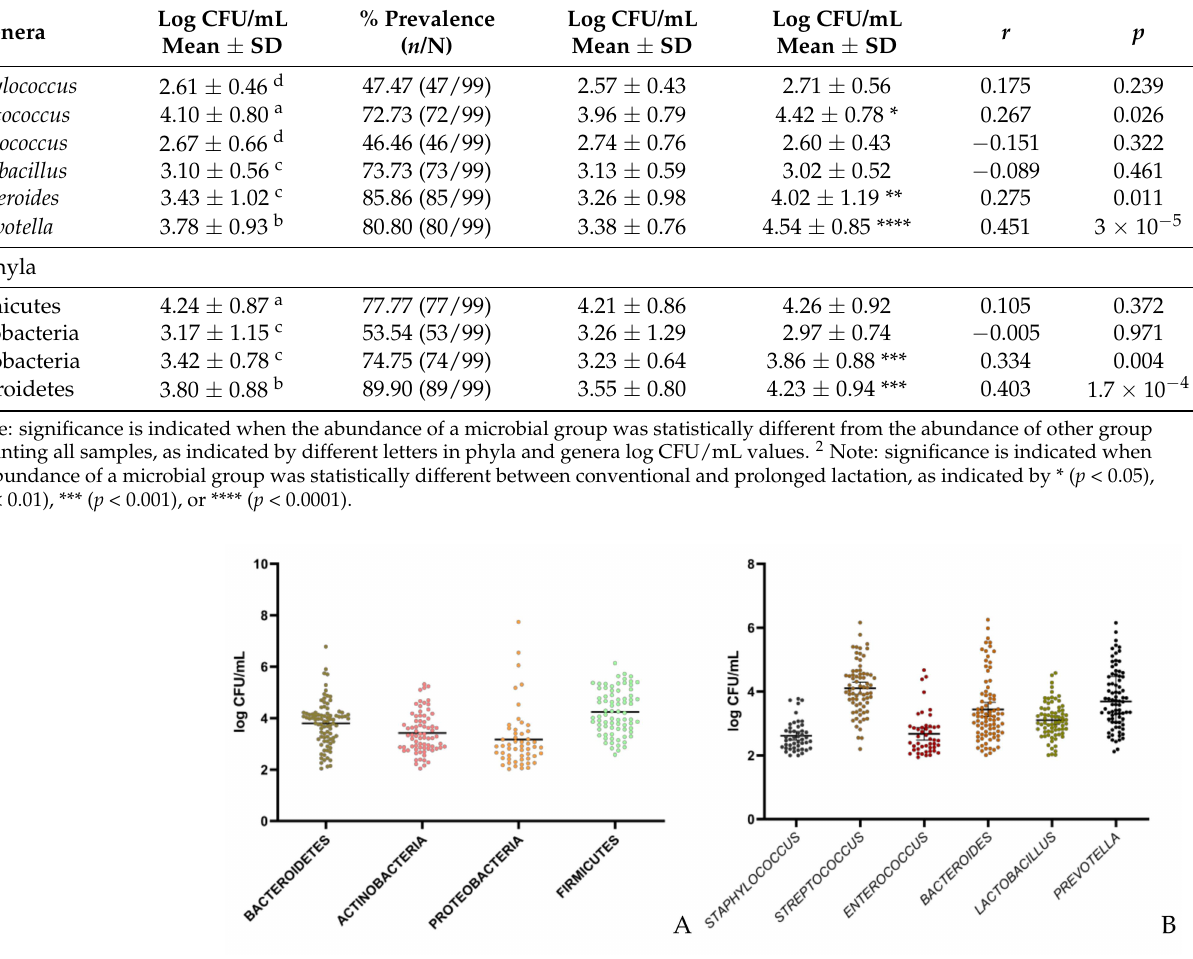
Figure 3. Grouped scatter plot showing the abundance (log CFU/mL) of the main bacterial phyla ( A ) and genera ( B ) of 99 breast milk samples collected from healthy Spanish mothers from two weeks to five years of continued